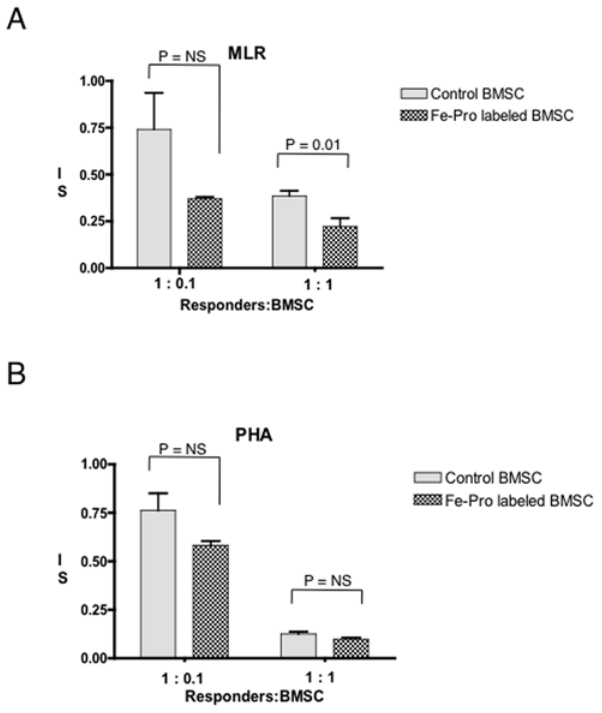
Figure 8. Mixed lymphocyte reaction (MLR) with Fe-Pro labeled hBMSCs. Bar graph showing the mean stimulation index (SI) for both, Fe-Pro labeled and unlabeled hBMSCs suppress T-cell proliferation in HLA mismatched MLR assay in response to alloreactive T-cells (A) and following nonspecific mitogen stimulation with phytohemagglutinin (PHA) (B). Control hBMSCs or Fe-Pro labeled hBMSCs were added at the ratios of 1:1 or 0.1:1 of non-irradiated PBMCs (responders) which proliferate in response to foreign histocompatibility antigens present on irradiated PBMCs (stimulators). Note, both the unlabeled control and Fe-Pro labeled hBMSCs suppressed MLR allo-reactivity in a dose- dependent manner. At the 1:1 responder to hBMSCs ratio, the PBMC induced stimulation index was significantly lower with Fe-Pro labeled